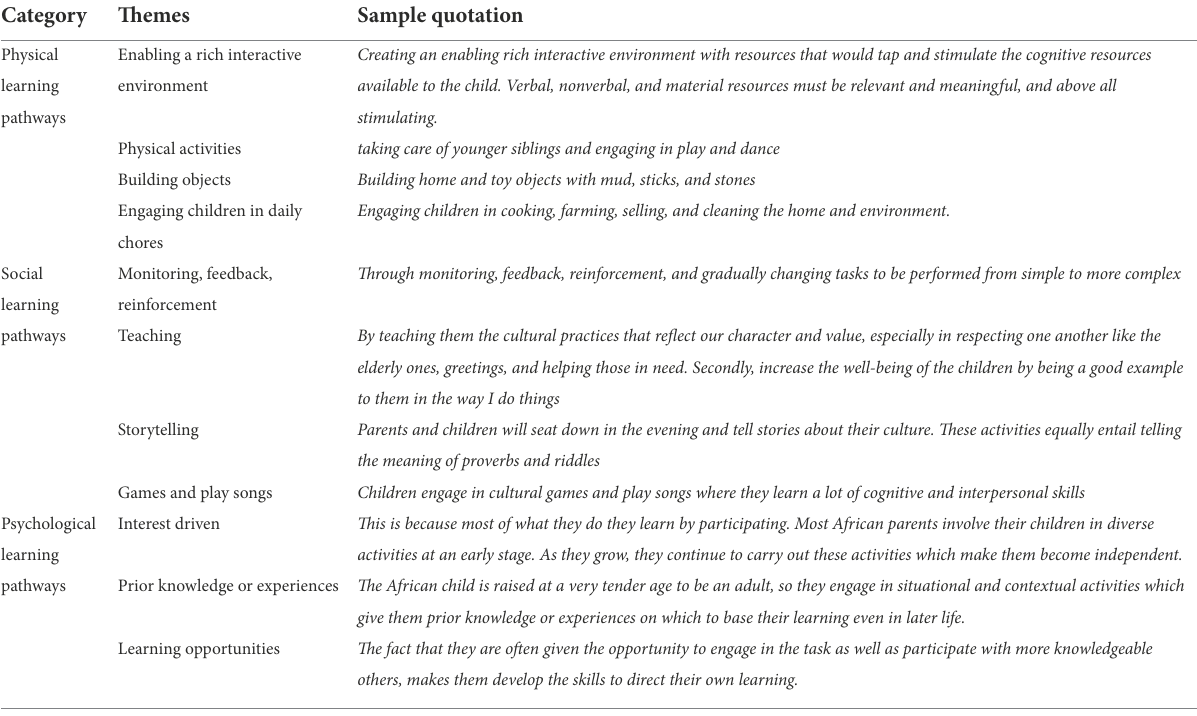
TABLE 8 Learning